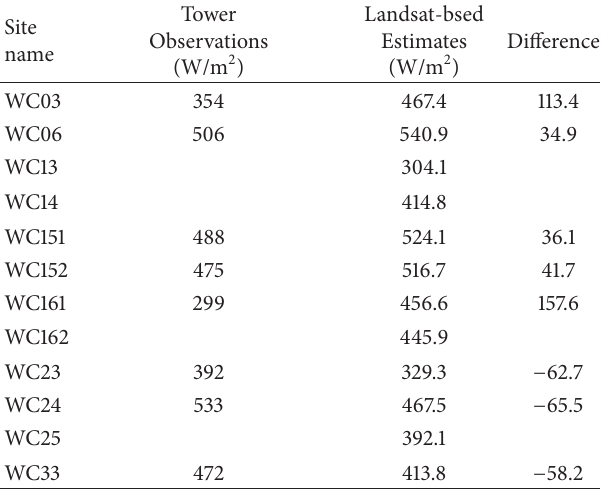
Table 3: Comparison between the observed latent heat flux and the estimates derived from Landsat-based